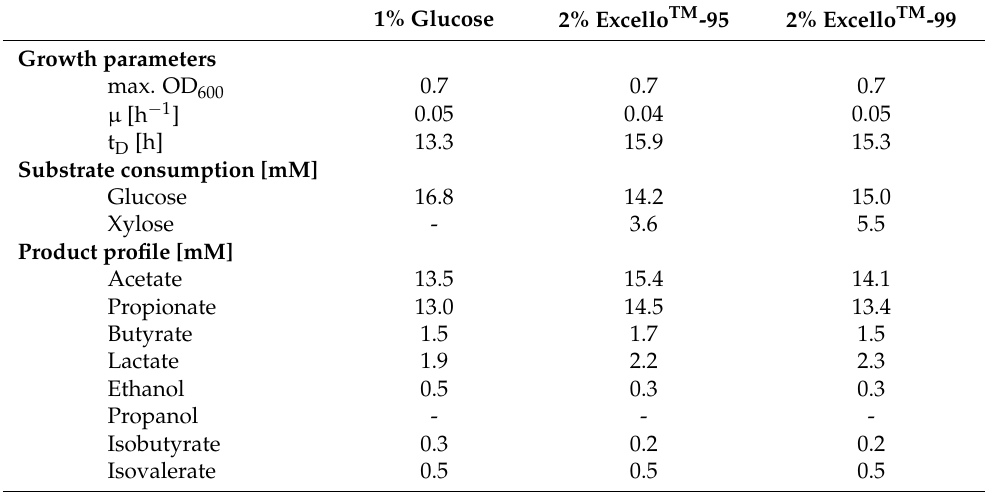
Table 3. Overview of growth parameters, substrate consumption, and product formation of A. neopro- pionicum when cultivated with different sugar substrates (1% ( w / v ) glucose or 2% ( w / v ) Excello TM ). Product concentrations refer to the mean titers at the end of cultivation ( n = 3). µ , growth rate; t D , doubling time; -, not